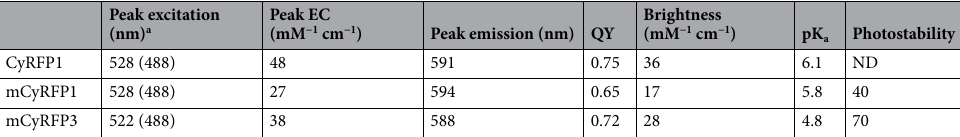
Table 1. Characteristics of mCyRFP3. EC extinction coefficient, QY quantum yield, ND not determined. a A secondary peak is listed in